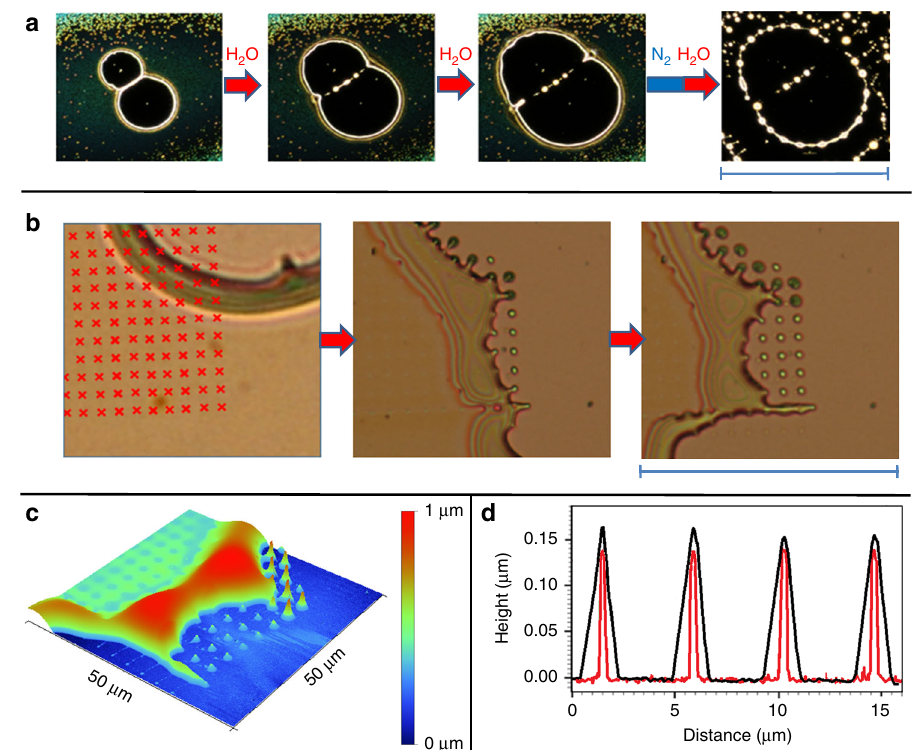
Fig. 6 Controlled structure formation. a Optical microscopy images (scale bar 430 µ m) of a controlled dewetting experiment with a [B 12 Br 12 ] 2 − -based layer. Exposure to wet gas induced formation of two neighboring holes that expanded during further exposure to water vapor. The wet gas fl ow was interrupted to acquire images a1 – a3, which immediately stopped growing. Growth of the holes continued when the surface was re-exposed to water vapor. After picture a3 was taken, the surface was stored for one night under nitrogen and again exposed to the wet gas fl ow. b Optical microscopy images (scale bar = 68 µ m). Part of the layer containing a growing hole was exposed to a focused electron beam (10 keV, 1.7 nC per irradiated spot) in the vacuum environment of a SEM. The red raster markers indicate the positions of e-beam irradiation. The development of the irradiated surface during further dewetting is shown in the following optical images. c AFM image showing the 3D morphology of the last optical image in b . d AFM line pro fi le over four neighboring tips (short free standing tips in c after the material front has passed (black) and after the surface was sonicated in methanol (red, see details in Supplementary Fig. 29), which dissolves non-irradiated areas of the deposit. The comparison shows that the electron beam induced shape is coated by